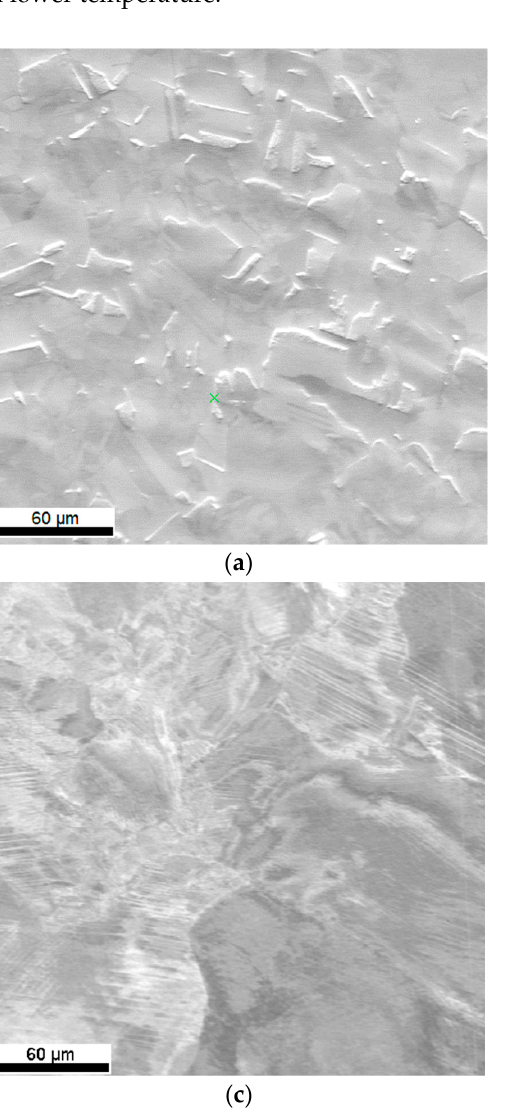
◦ C and − 1 − 1 − 1 and 5 × 10 3 s strain rate. Only at 5 × 10 3 s strain rate and